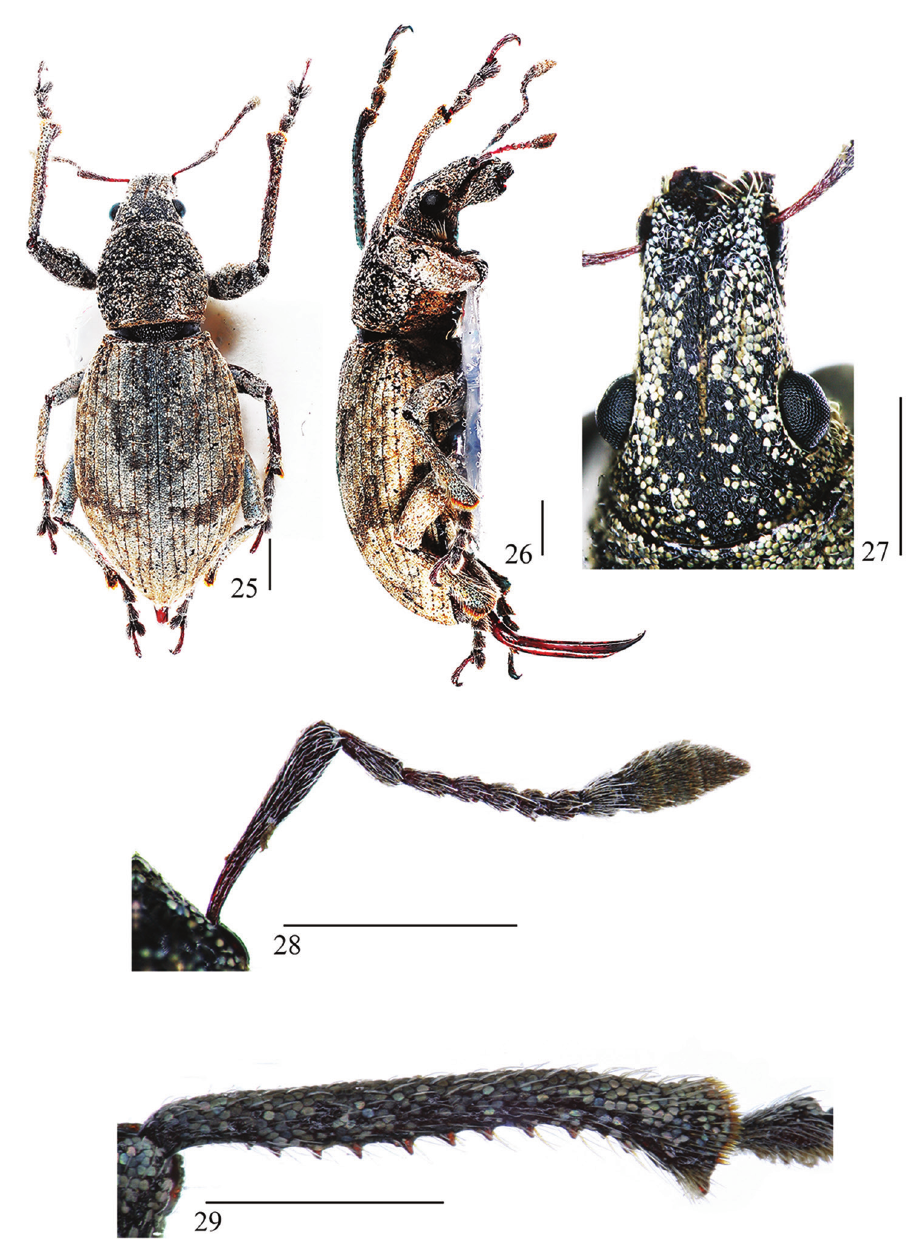
Figures 25–29. Habitus of Geotragus granulatus (Chao, 1980): 25 male, dorsal view 26 male, lateral view 27 male, head and rostrum, anterior view 28 male, antenna, anterior view 29 male, left protibia, anterior view. Scale bars 1